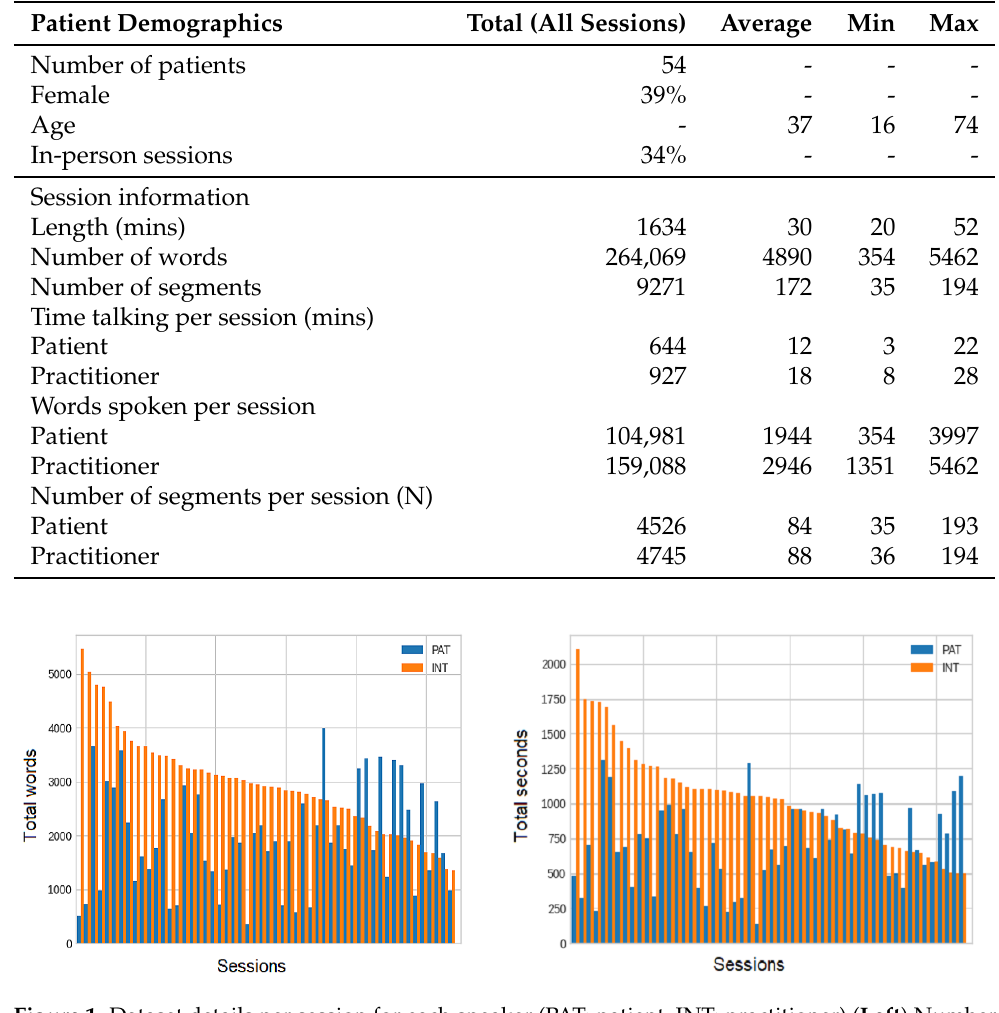
Figure 1. Dataset details per session for each speaker (PAT: patient, INT: practitioner) ( Left ) Number of words. ( Right ) Total